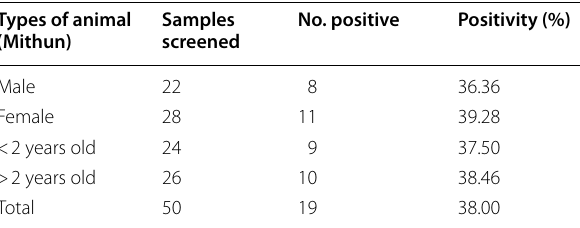
Table 11 Seroprevalence of anti-BTV antibodies among Mithun of Nagaland Types of animal